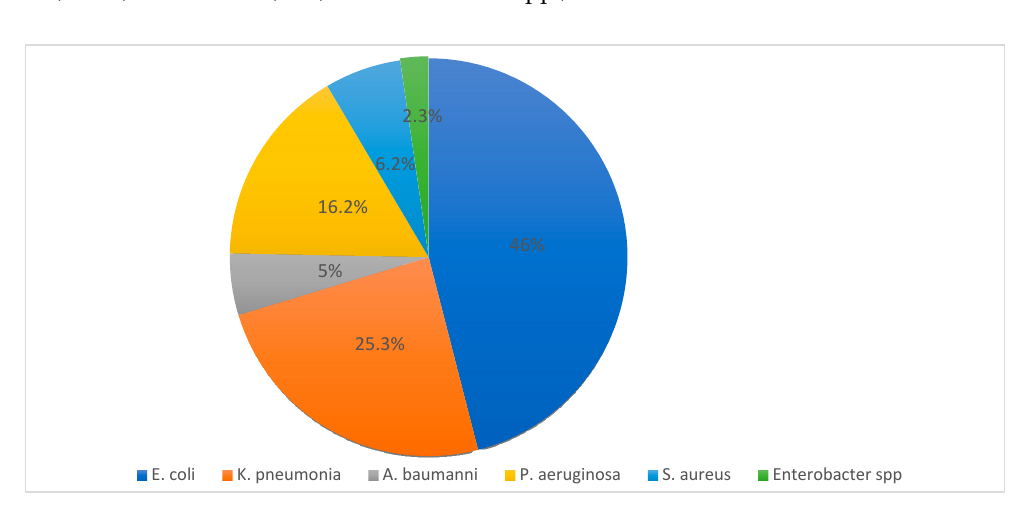
Figure 2. Percentage of distribution of E. coli and ESKAPE pathogens in the Arab region during